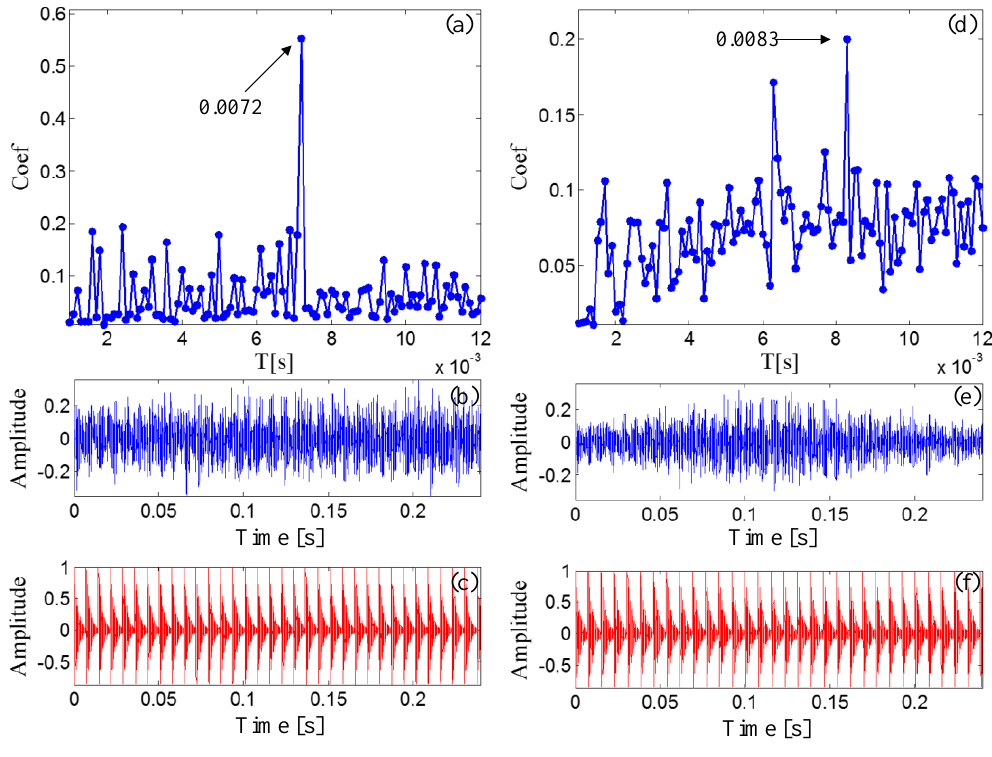
Figure 20. Results for Doppler-shifted bearing signal with the out-race defect using the transient model analysis method ( a ) maximal correlation coefficients for different elements from set T after Doppler effect elimination; ( b ) wave form of the Doppler-free signal; ( c ) the optimal periodical transient model for the Doppler-free signal; ( d ) maximal correlation coefficients for different elements from set T before Doppler effect elimination; ( e ) wave form of the Doppler-shifted signal; ( f ) the optimal periodical transient model for the Doppler-shifted